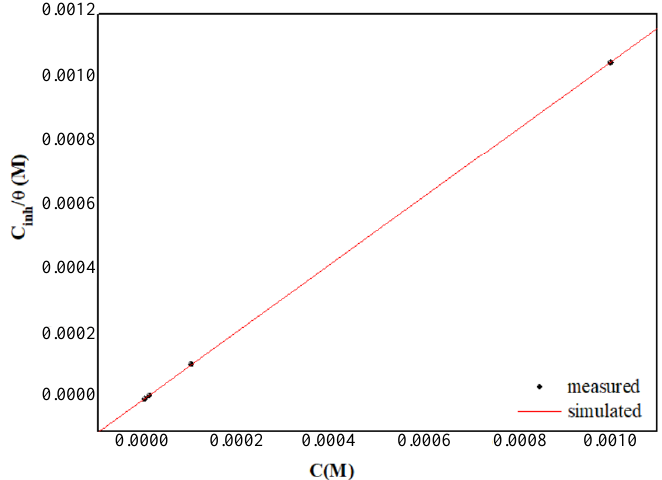
Figure 5. Langmuir adsorption of PPD on (MS) surface in molar HCl. The values of the adsorption coefficient ( K ads ), determined by extrapolation of the